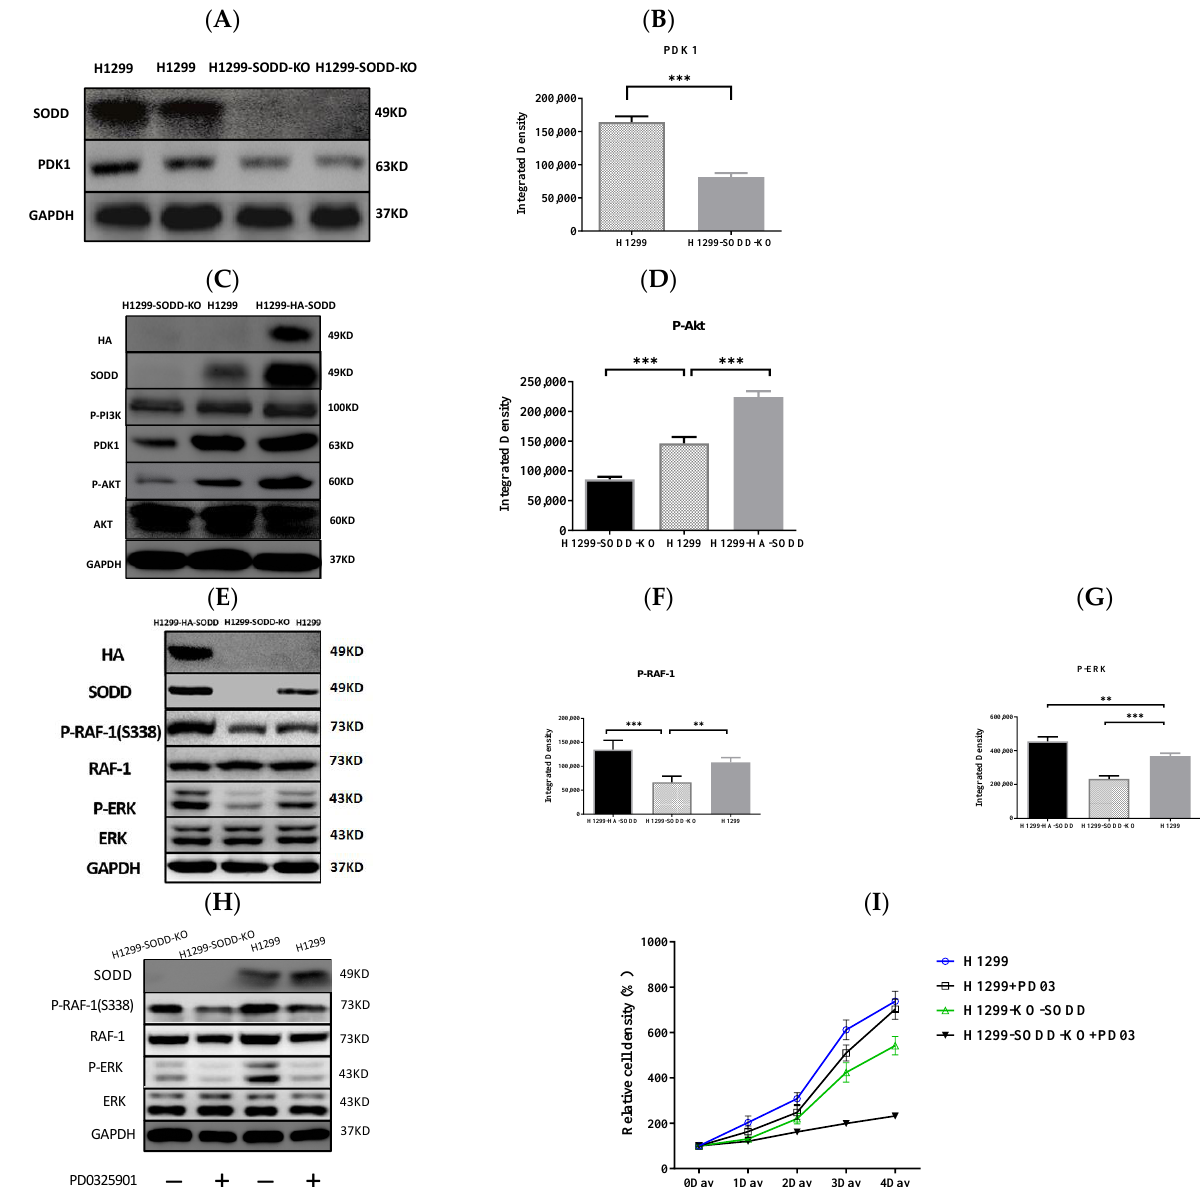
Figure 5. Effect of SODD expression on PDK1/AKT and RAF-1/ERK cascades. ( A , B ) PDK1 expres- sion in the SODD-KO and WT H1299 cells was detected by WB. ( C ) WB shows the effect of SODD knockout on the PDK1/AKT signals in response to EGF. ( D ) Phospho-AKT (S308) in H1299-HA-SODD, SODD-KO, and WT H1299 cells. ( E ) WB shows the phosphorylation level of RAF-1 and ERK in SODD-KO, HA-SODD, and WT H1299 cells. ( F , G ) Phospho-RAF-1 and ERK in H1299-HA-SODD,SODD-KO,and WT H1299 cells. ( H , I ) WB shows the total and phosphorylated RAF and ERK in SODD-KO and WT H1299 cells treated with PD0325901 and the correspondent cell growth curve (H) (** p < 0.01,*** p < 0.001 versus control). RAF-1 S338 phosphorylation was reduced in SODD-KO H1299 cells. Simultaneous-